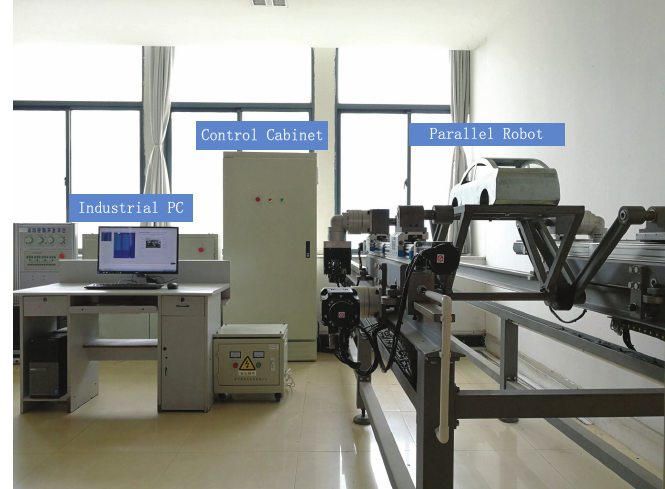
Figure 7. The prototyping system of the CPR.